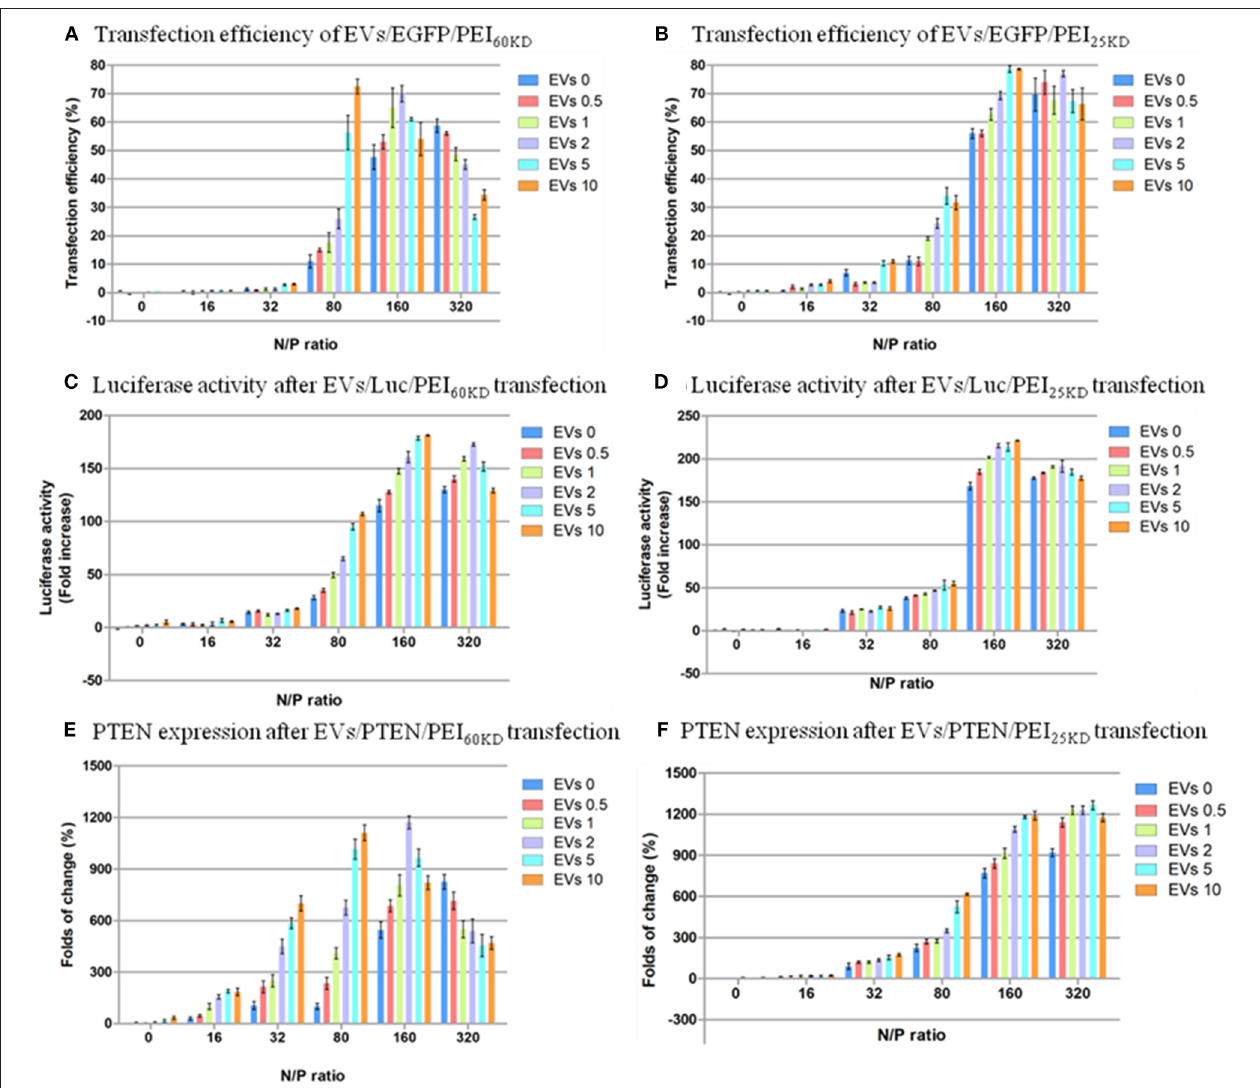
FIGURE 5 | Transfection efficiency of HEK293T cells by plasmid EGFP using (A) PEI 60kD and (B) PEI 25kD ; Luciferase activity after transfection using (C) PEI 60kD and (D) PEI 25kD ; PTEN expression after transfection using (E) PEI 60kD and (F) PEI 25kD ; determined by MTT assay, at a post transfection time of 48h for different N/P ratios. EV solution of different volume (0, 0.5, 1, 2, 5, and 10 µ L) with protein concentration of 3 ng/ µ L − 1 were added into each well of the 96-well